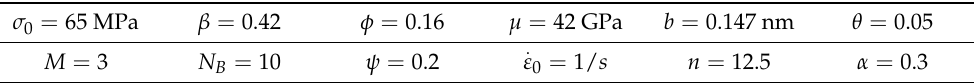
Table 1. Parameters in